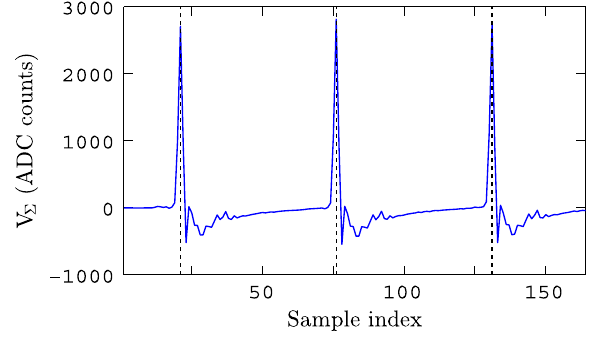
FIG. 17. Example recorded V Σ waveform for a train of three bunches with an interbunch separation of 154 ns. The bunch samples are indicated by the vertical dotted lines.